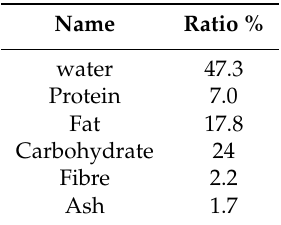
Table 1. Composition of processed Cornish